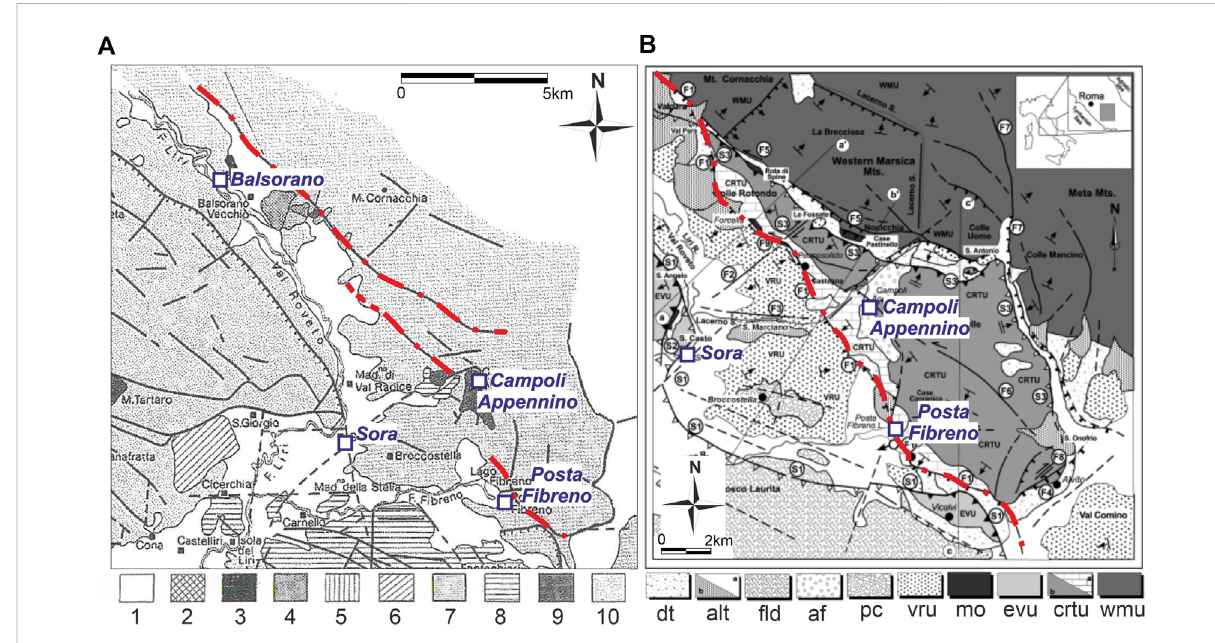
FIGURE 2 (A) Geological schemeof the study area proposed by Carrara et al., 1995a where the Roveto Valley Faulttrace isindicated by ared dash-dotted line. The legend provided in the work of Carrara et al., 1995a: 1) deposits more recent than the breccias of the fourth depositional phase; 2) chaotic deposit;3)brecciasofthefourthdepositionalphase;4)brecciasofthethirddepositionalphase;5)alluvialfan;6)overlappingofthesecond,thirdand fourth breccias depositional phase; 7) breccias of the second depositional phase; 8) fl uvial and lacustrine deposits; 9) breccias of the fi rst depositional phase; and 10) Meso-Cenozoic carbonate bedrock. (B) Geological scheme of the study area proposed by Saroli et al. (2003) where the Posta Fibreno Fault trace is marked by a red dash-dotted line. Legend provided in the work of Saroli et al. (2003): (dt)- talus material and “ red soils ” , fl uvial-terraced, lacustrine, and travertine deposits; (alt-b)- recent alluvial fans; ( fl d)- braided fl uvial and lacustrine deposits; (af)- ancient cemented alluvial fans; (pc)- poligenic conglomerates with allogenic elements; (caf)- Miocene fl ysch, (mo)- “ Marne a Orbulina ” formation (Miocene); and (evu, crtu-a, crtu-b, wmu)- Meso-Cenozoic carbonate